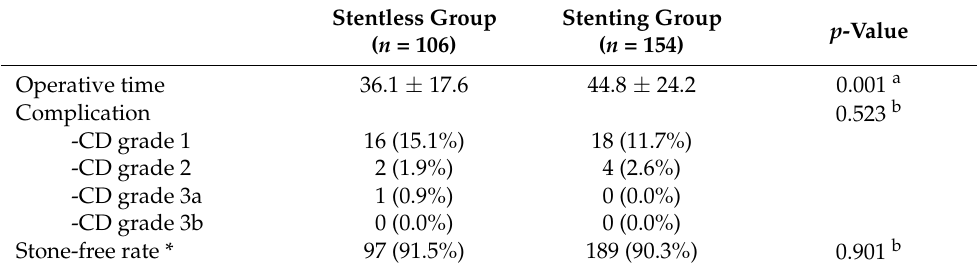
Table 2. Differences in surgical outcomes with and without preoperative stenting. Stentless Group ( n = 106) ( n = 154)